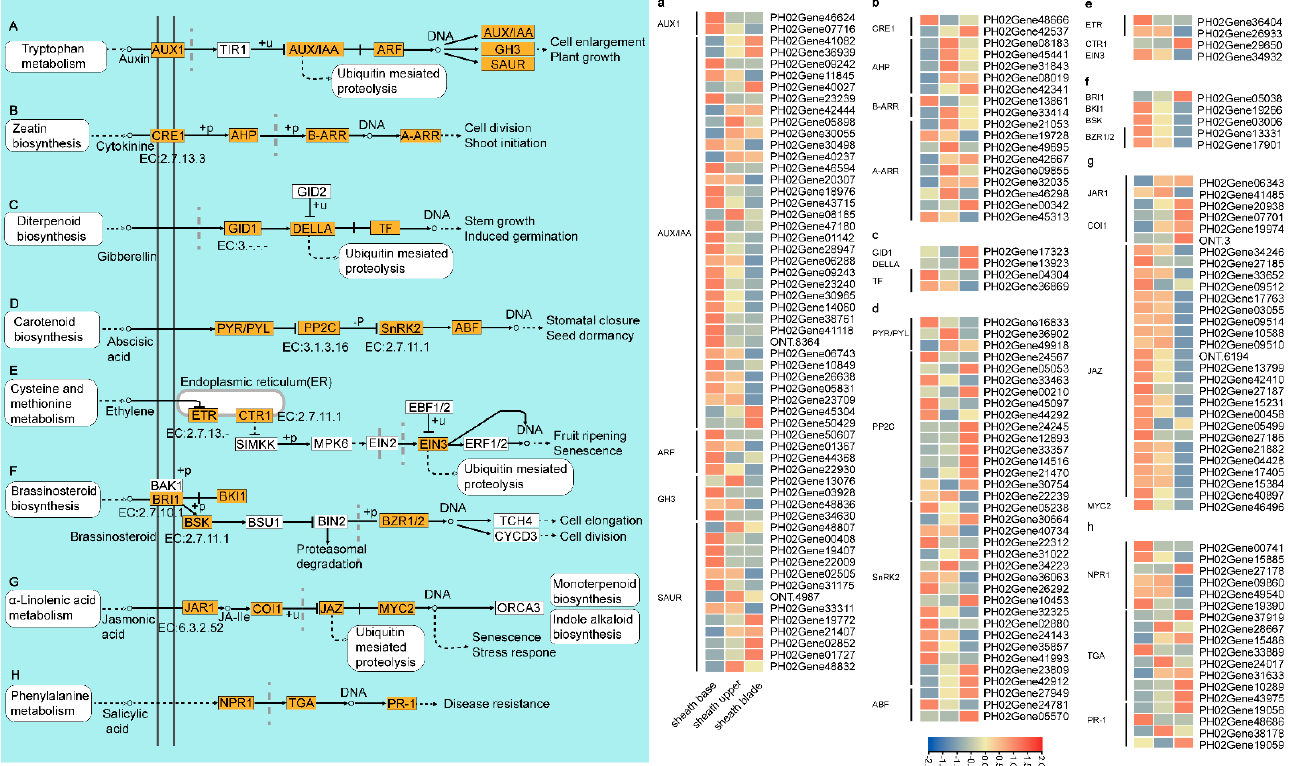
Figure 6. Expression changes in plant hormone signal transduction pathway-related DEGs in the culm sheath. ( A – H ) Schematic diagram of plant hormone signal transduction. ( a – h ) Heatmap of genes related to plant hormone signal transduction. The DEGs in this study are indicated by colored, shaded